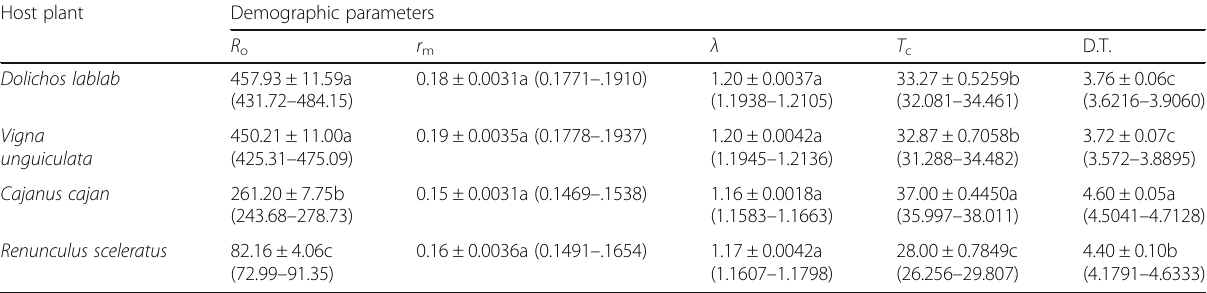
Table 2 Demographic attributes of H. variegata when fed on aphid, A. craccivora , infested on four host plants